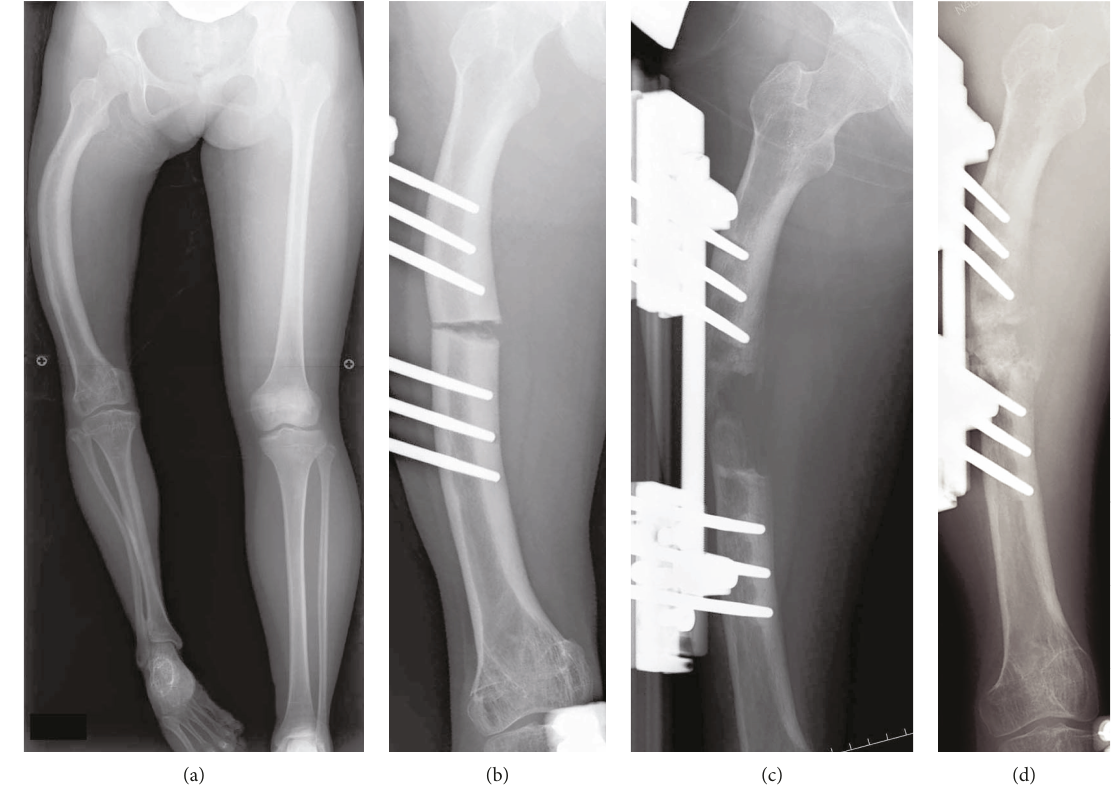
Figure 2: Radiographs of the lower extremities at the time of the second lengthening. (a) An anteroposterior supine radiograph of the lower extremities at eleven years of age before the second lengthening revealing LLD of 11cm. (b) A radiograph of the right femur just after the femoral osteotomy demonstrating acute correction of an anterolateral bowing deformity. (c, d) Radiographs of the right femur before (c) and after (d) the chipping